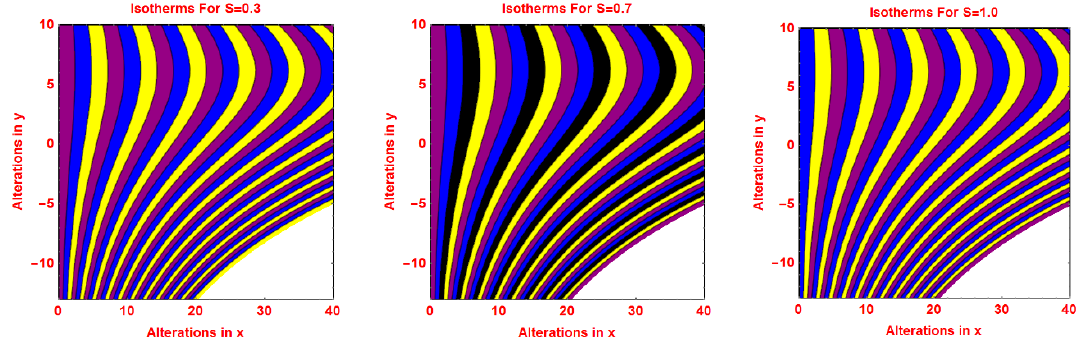
Figure 10. Effects of different values of S on isotherms pattern.